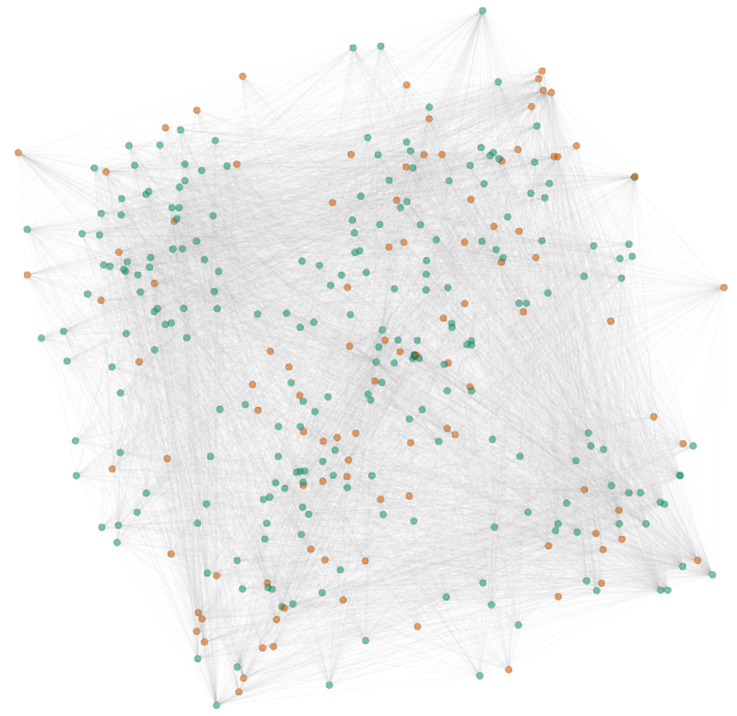
Integrated patient similarity network, generated by combining all networks that consistently pass feature selection.This network is generated by calling
plotIntegratedPatientNetwork() and uses RCy3 to programmatically generate the network in Cytoscape
7,
8. This network uses features that scored 2 out of 2 in all train-test splits. For visualization, only the top 8% most-distant edges are shown. Nodes are patients, and edges weights show average similarity across all features passing feature selection. Node fills indicate patient label, with “LumA” in green and “nonLumA” in orange.